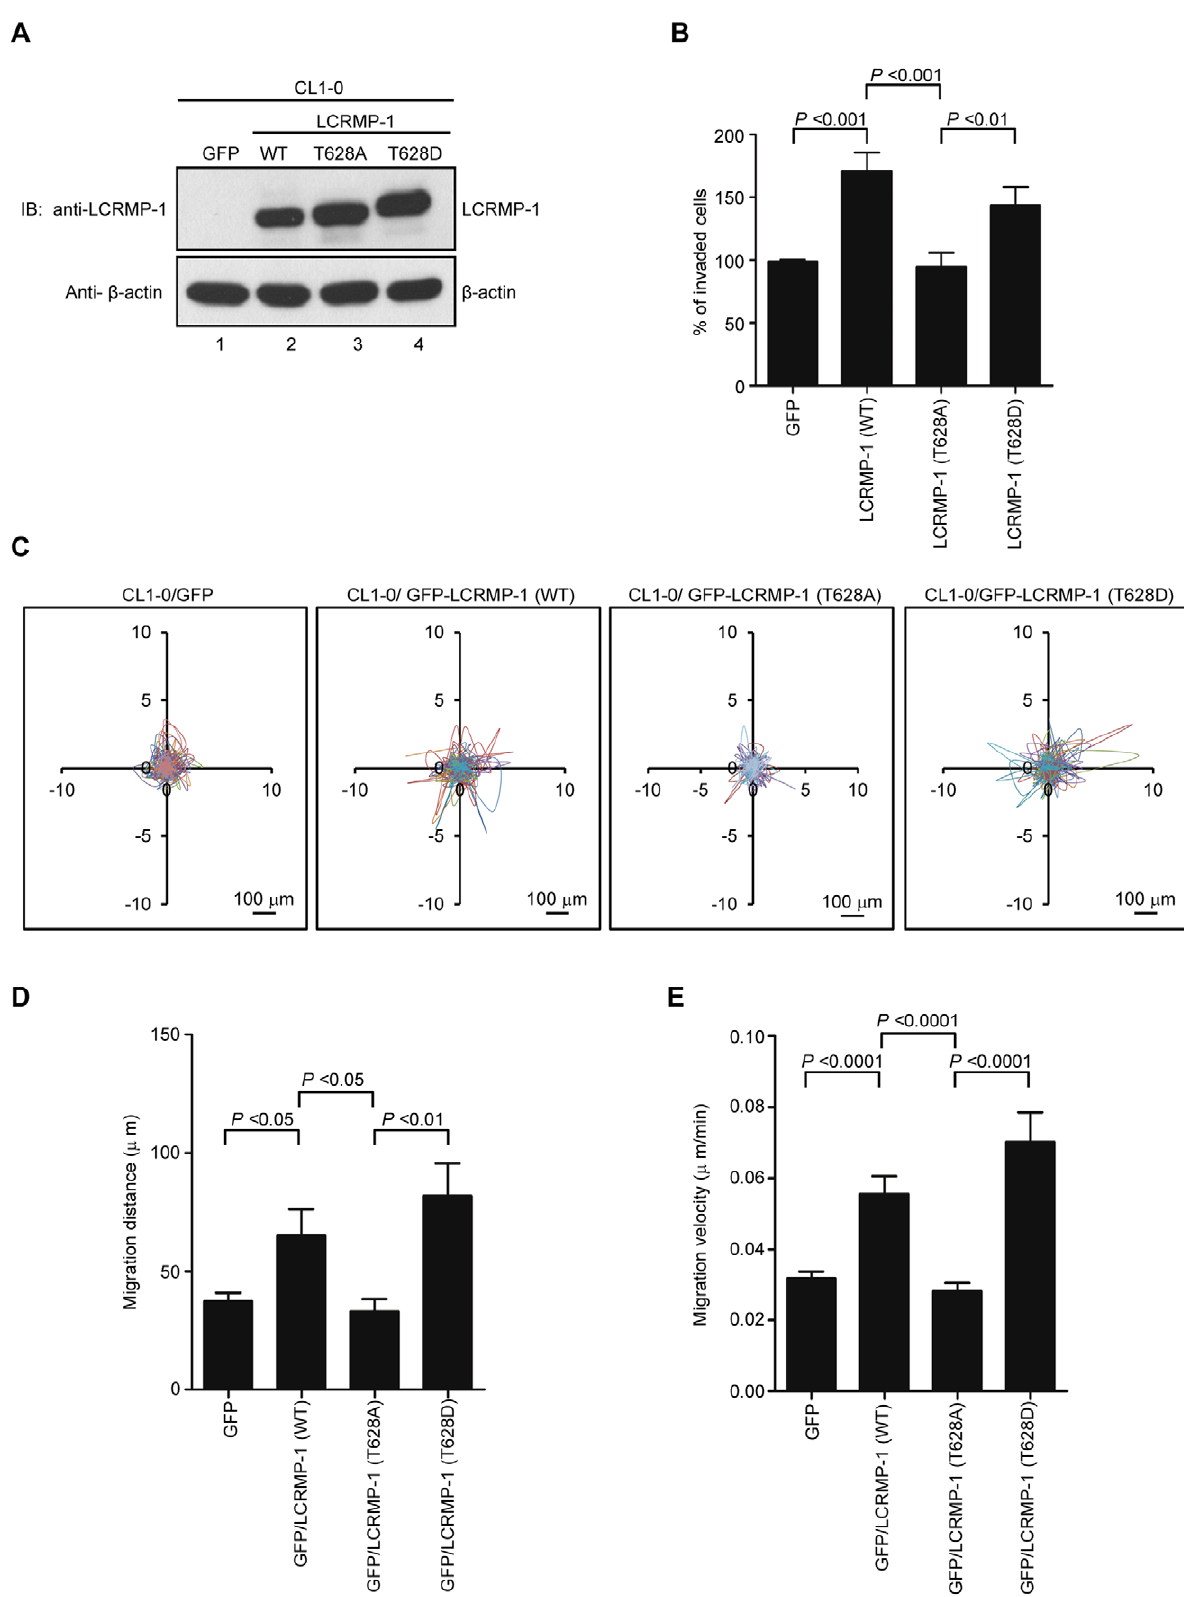
Figure 2. Phosphorylation of LCRMP-1 at Thr-628 is critical for cancer invasion and migration. (A) Protein expression levels of exogenous untagged LCRMP-1 (WT), LCRMP-1 (T628A), and LCRMP-1 (T628D) are confirmed by immunoblotting. After 48 hours post lentivirus infection, CL1-0 cells were stably expressing wild-type and mutant LCRMP-1. Lentivirus expressing GFP served as control. Cell lysates were harvested, following by